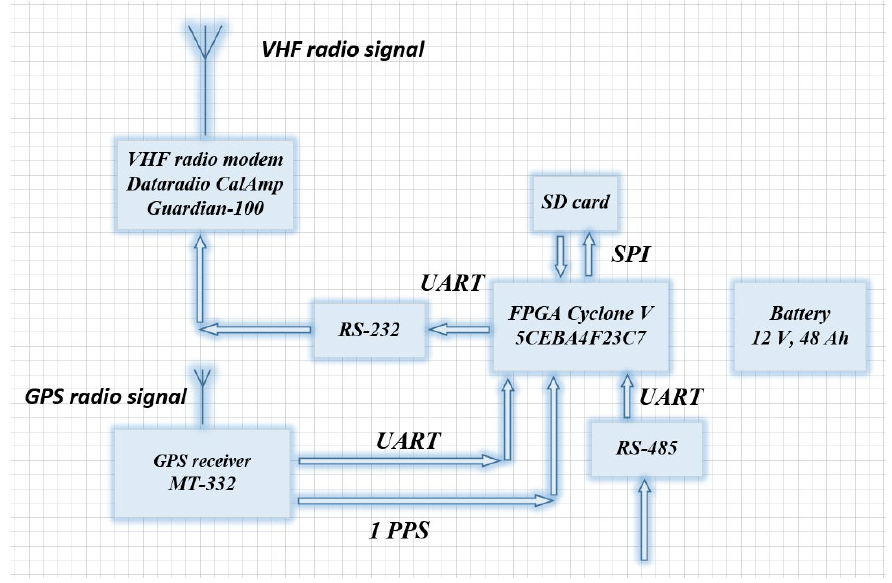
Figure 5. View of the deployed beacon.